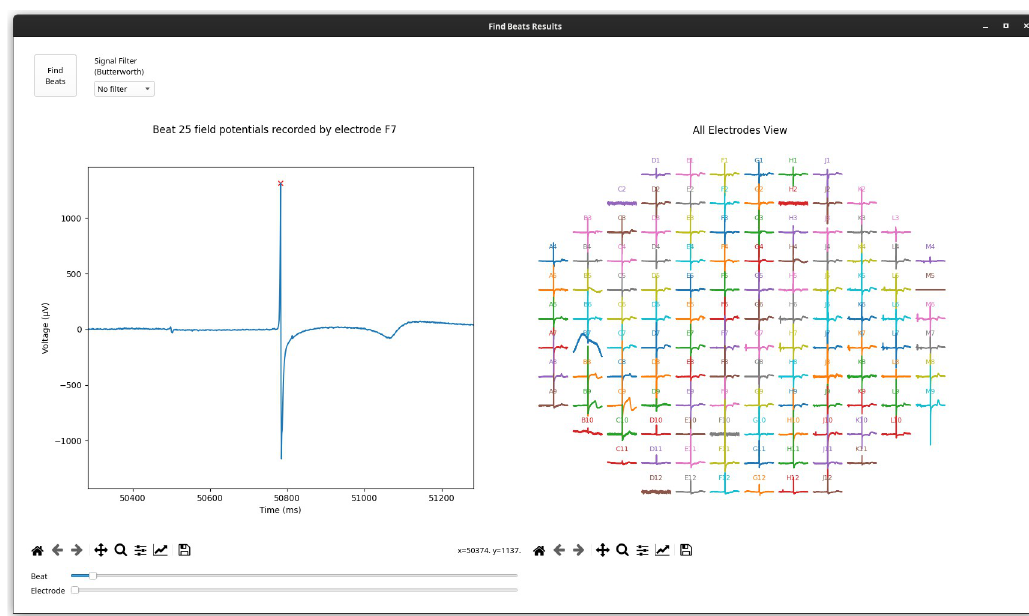
Fig 4. ‘Find Beats Results’ window. The left plot shows an individual beat for the electrode specified by the window slider. The sliders below the plot control which beat and/or electrode is plotted. The right plot shows the full MEA for a specified beat and is controlled by the same ‘Beat’ slider as the left